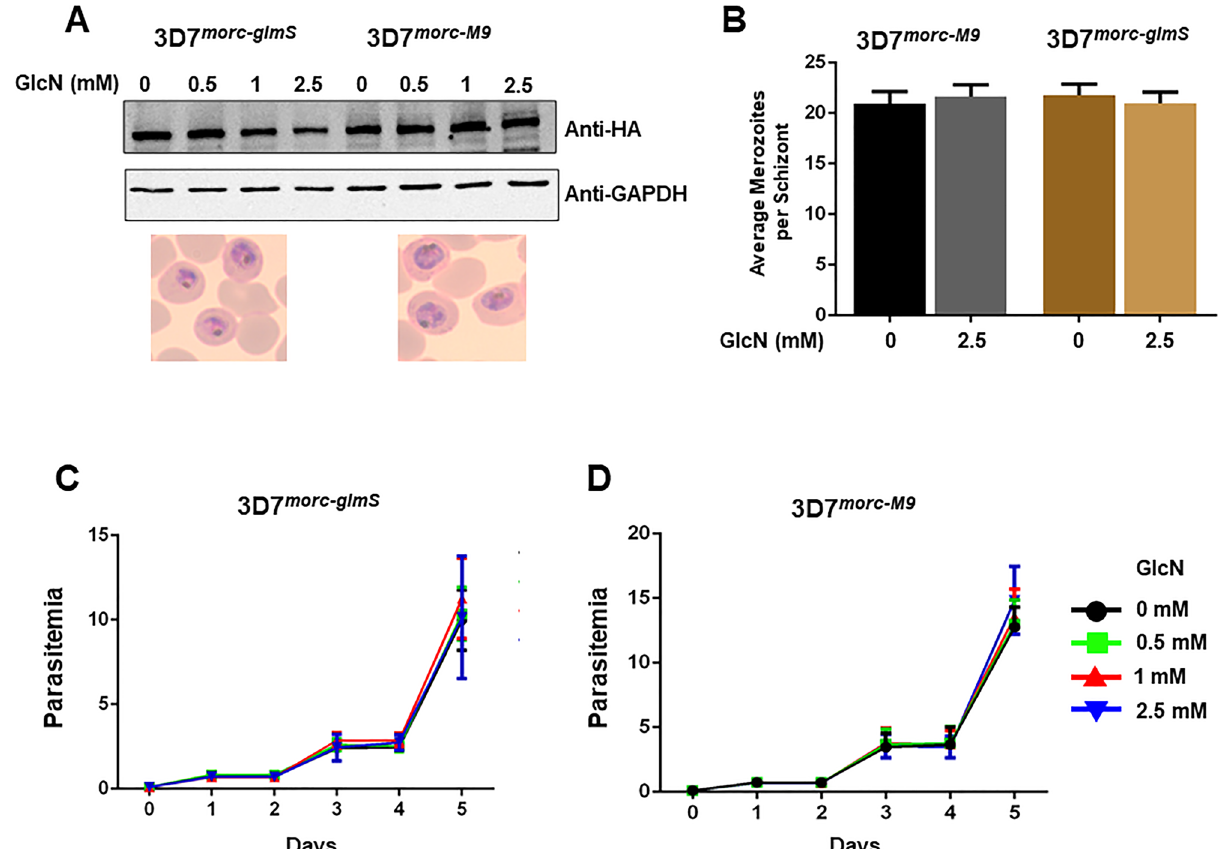
Figure 4. Effect of glucosamine treatment in conditional knockdown of PfMORC parasites. ( A ) Western blot analysis of 3D7 morc-glmS parasites treated with 0–2.5 mM of glucosamine for 48 h showing reduced protein expression, but the control 3D7 morc-M9 parasites did not exhibit down regulation in protein level. ( B ) Early trophozoites were treated with and without 2.5 mM glucosamine till the next cycle and smears were made when majority of parasites reached to segmented schizont. The average of merozoites per schizont in populations was obtained by counting at least 50 parasites for each replicate. ( C ) Parasitemia was monitored for 6 days in the presence of a different concentration of glucosamine in the media for 3D7 morc-glmS and ( D ) 3D7 morc-M9 . No significant statistical difference was observed when unpaired t-test was